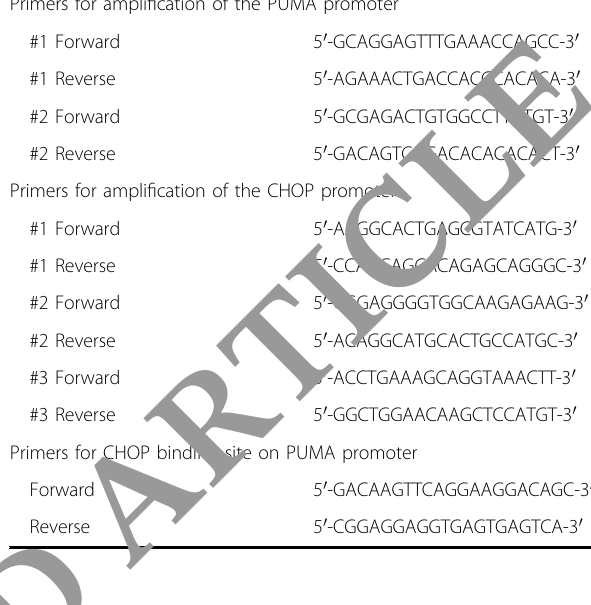
Table 2 PCR primers. Table 3 ChIP primers. Primers for ampli fi cation of the PUMA